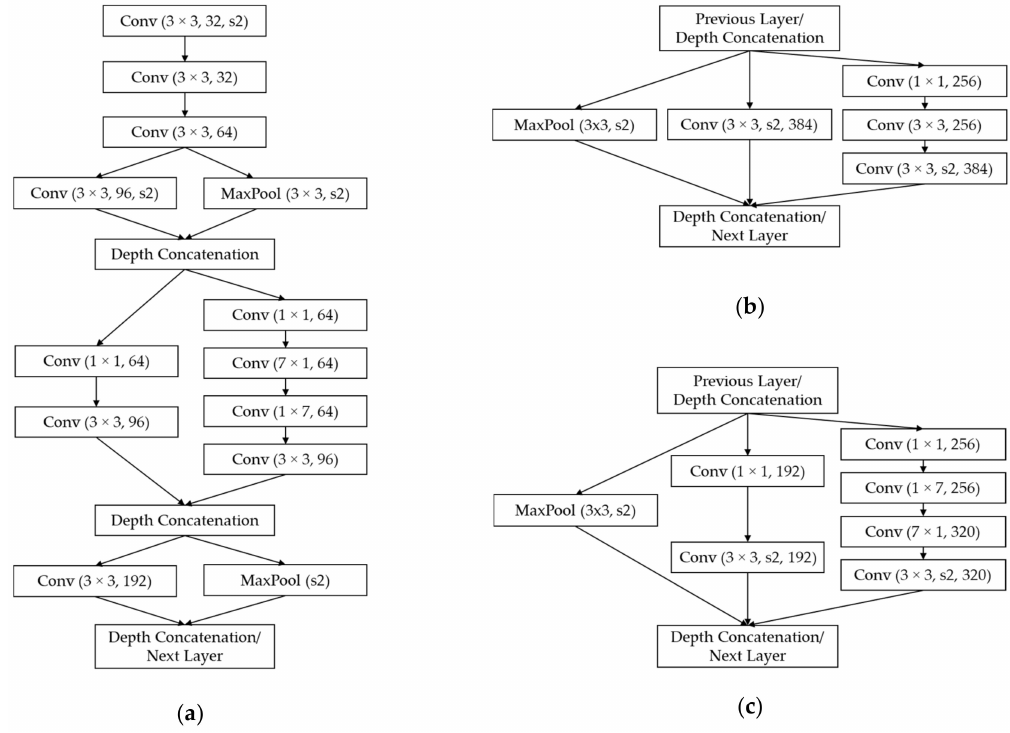
Figure 7. Structures of other blocks in Inception-ResNet-v2 architectures: ( a ) Stem, ( b ) Reduction-A, and ( c ) Reduction-B in Figure 4c. “s2” denotes a stride number of